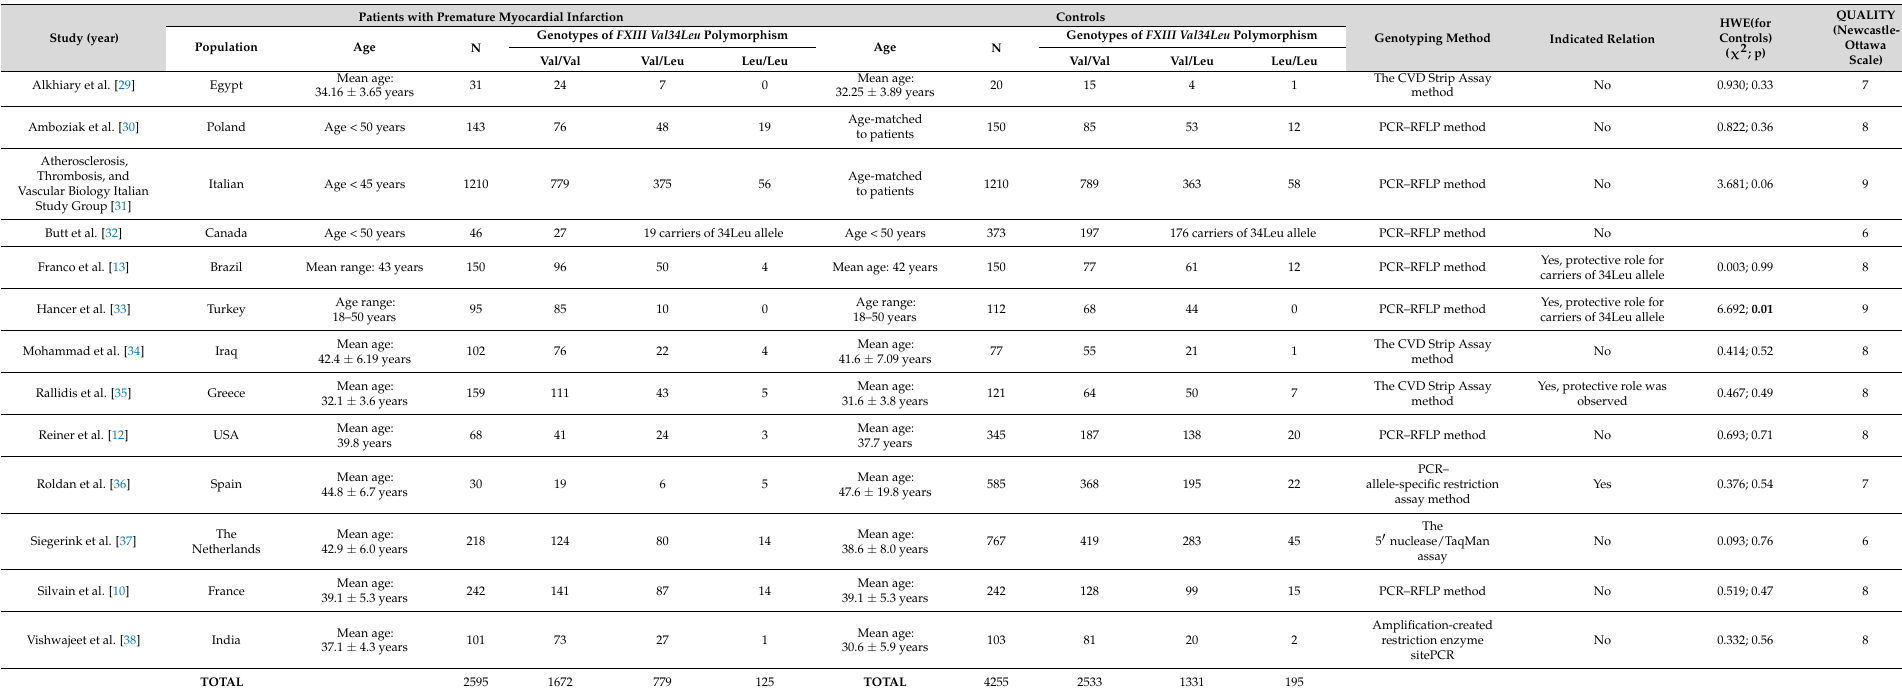
Table 3. Characteristics of the studies included to the meta-analysis regarding relation between FXIII Val34Leu polymorphism and myocardial infarction in young